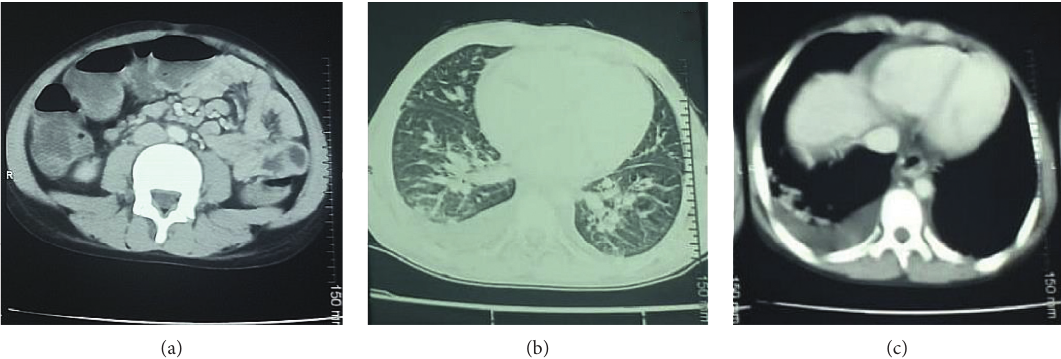
Figure 3: CTscan images showing (a) inflammation of the small bowel, air-fluid levels, reactional mesenteric lymphadenopathy, and (b), (c) right-sided pleurisy with bilateral pulmonary